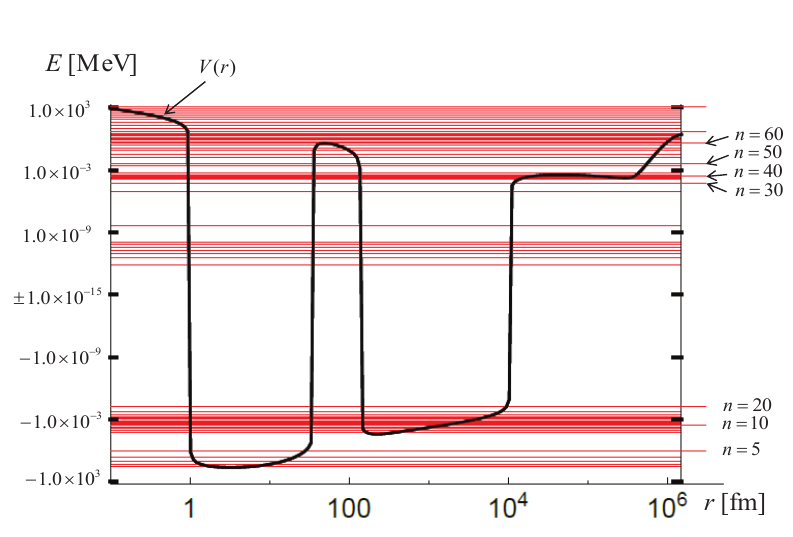
Figure 1: Three-body energy levels and potential “with the long range potential”. The attractive potential part of the shorter range (fm region) indicates mainly the nuclear WS potential, and the next attractive part of 10 3 fm region comes from mainly the GPT potential, and the final hollow in the 10 5 fm region is the Coulomb attractive potential by the Cs ion and the Pd cage. n is the principal quantum number. 1 ≤ n ≤ 5 shows the La nuclear levels, 6 ≤ n ≤ 20 are special levels by the GPT potential which belong to the nuclear excited states, and 21 ≤ n ≤ 60 states represent the molecular levels for CsD , 2